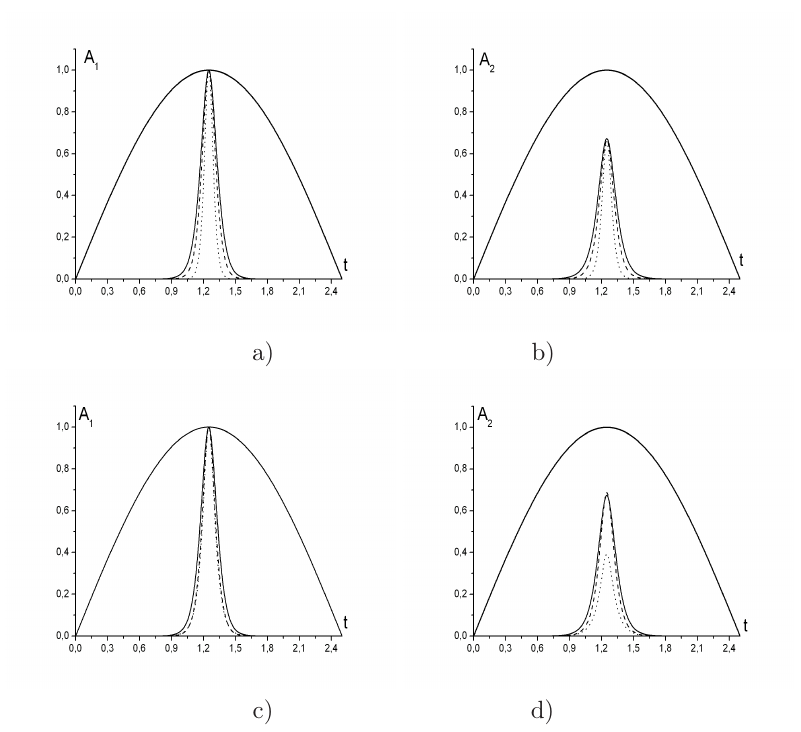
Figure 2. Shape of pulse for solitary wave on fundamental (a,c) and doubled (b,d) frequency corresponding to the first eigenvalue under the fixed value δ α = 0 (a,b) for n γ = 1 , δ γ = 0 (solid line), δ = 1 (dashed line), δ = 5 (dotted line) or under the fixed value δ γ γ for n α = 1 , δ α = 0 (solid line), δ α = 1 (dashed line), δ α = 5 (dotted